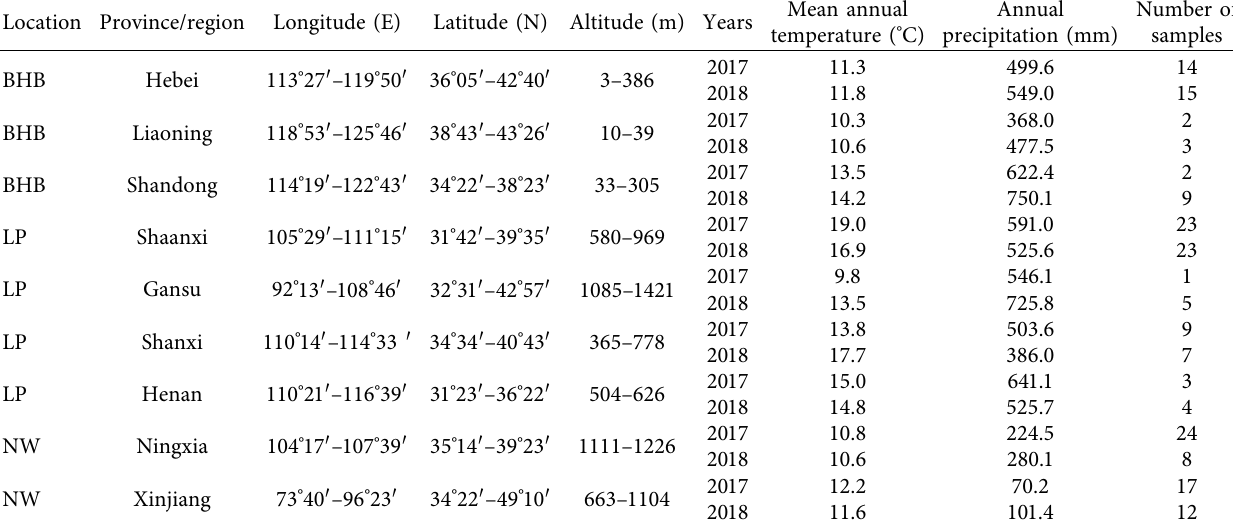
Table 1: The region information of apple